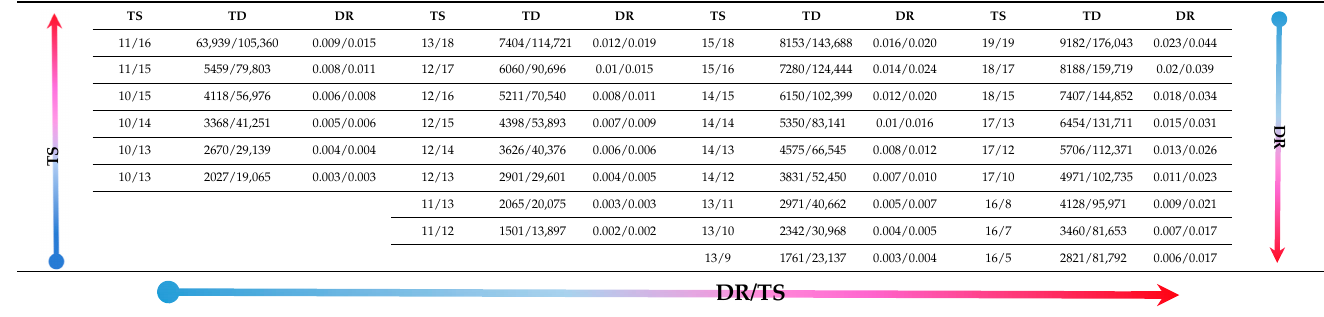
( g ) ( h ) Figure 5. Changes in the number of TPG with different daily detectability. ( a )The daily detectabil- ity from 700,000 cases to 750,000 cases with an interval of 10,000 cases in HK; ( b )The daily detecta- Figure 5. Changes in the number of TPG with different daily detectability. ( a )The daily detectabil- bility between [7,000,000 cases 7,500,000 cases] with an interval of 50,000 in US; ( c ) The daily de- Figure 5. Changes in the number of TPG with different daily detectability. ( a ) The daily detectability ity from 700,000 cases to 750,000 cases with an interval of 10,000 cases in HK; ( b )The daily detecta- tectability between [600,000 cases 670,000 cases] with an interval of 10,000 in HK; ( d )The daily de- bility between [7,000,000 cases 7,500,000 cases] with an interval of 50,000 in US; ( c ) The daily de- from 700,000 cases to 750,000 cases with an interval of 10,000 cases in HK; ( b ) The daily detectability tectability between [6,000,000 cases 6,700,000 cases] with an interval of 50,000 in US; ( e ) The daily tectability between [600,000 cases 670,000 cases] with an interval of 10,000 in HK; ( d )The daily de- between [7,000,000 cases 7,500,000 cases] with an interval of 50,000 in US; ( c ) The daily detectability tectability between [6,000,000 cases 6,700,000 cases] with an interval of 50,000 in US; ( e ) The daily detectability between [500,000 cases 580,000 cases] with an interval of 10,000 in HK; ( f )The daily between [600,000 cases 670,000 cases] with an interval of 10,000 in HK; ( d ) The daily detectability ( h ) detectability between [500,000 cases 580,000 cases] with an interval of 10,000 in HK; ( f )The daily detectability between [5,000,000 cases 5,800,000 cases] with an interval of 50,000 in US; ( g ) The between [6,000,000 cases 6,700,000 cases] with an interval of 50,000 in US; ( e ) The daily detectability detectability between [5,000,000 cases 5,800,000 cases] with an interval of 50,000 in US; ( g ) The Figure 5. Changes in the number of TPG with different daily detectability. ( a )The daily detectabil- Figure 5. Changes in the number of TPG with different daily detectability. ( a )The daily detectabil- daily detectability between [400,000 cases 480,000 cases] with an interval of 10,000 in HK; ( h )The ity from 700,000 cases to 750,000 cases with an interval of 10,000 cases in HK; ( b )The daily detecta- daily detectability between [400,000 cases 480,000 cases] with an interval of 10,000 in HK; ( h )The ity from 700,000 cases to 750,000 cases with an interval of 10,000 cases in HK; ( b )The daily detecta- between [500,000 cases 580,000 cases] with an interval of 10,000 in HK; ( f ) The daily detectability daily detectability between [4,000,000 cases 4,800,000 cases] with an interval of 50,000 in US; bility between [7,000,000 cases 7,500,000 cases] with an interval of 50,000 in US; ( c ) The daily de- bility between [7,000,000 cases 7,500,000 cases] with an interval of 50,000 in US; ( c ) The daily de- daily detectability between [4,000,000 cases 4,800,000 cases] with an interval of 50,000 in US; between [5,000,000 cases 5,800,000 cases] with an interval of 50,000 in US; ( g ) The daily detectability tectability between [600,000 cases 670,000 cases] with an interval of 10,000 in HK; ( d )The daily de- tectability between [600,000 cases 670,000 cases] with an interval of 10,000 in HK; ( d )The daily de- tectability between [6,000,000 cases 6,700,000 cases] with an interval of 50,000 in US; ( e ) The daily tectability between [6,000,000 cases 6,700,000 cases] with an interval of 50,000 in US; ( e ) The daily between [400,000 cases 480,000 cases] with an interval of 10,000 in HK; ( h ) The daily detectability Table 7. Model Simulation Results of the All-People Test Based on Binary Coding Table 7. Model Simulation Results of the All-People Test Based on Binary Coding HK/US. detectability between [500,000 cases 580,000 cases] with an interval of 10,000 in HK; ( f )The daily detectability between [500,000 cases 580,000 cases] with an interval of 10,000 in HK; ( f )The daily detectability between [5,000,000 cases 5,800,000 cases] with an interval of 50,000 in US; ( g ) The between [4,000,000 cases 4,800,000 cases] with an interval of 50,000 in US. detectability between [5,000,000 cases 5,800,000 cases] with an interval of 50,000 in US; ( g ) The daily detectability between [400,000 cases 480,000 cases] with an interval of 10,000 in HK; ( h )The daily detectability between [400,000 cases 480,000 cases] with an interval of 10,000 in HK; ( h )The daily detectability between [4,000,000 cases 4,800,000 cases] with an interval of 50,000 in US; daily detectability between [4,000,000 cases 4,800,000 cases] with an interval of 50,000 in US; Table 7. Model Simulation Results of the All-People Test Based on Binary Coding HK/US. Table 7. Model Simulation Results of the All-People Test Based on Binary Coding HK/US. Table 7. Model Simulation Results of the All-People Test Based on Binary Coding HK/US.